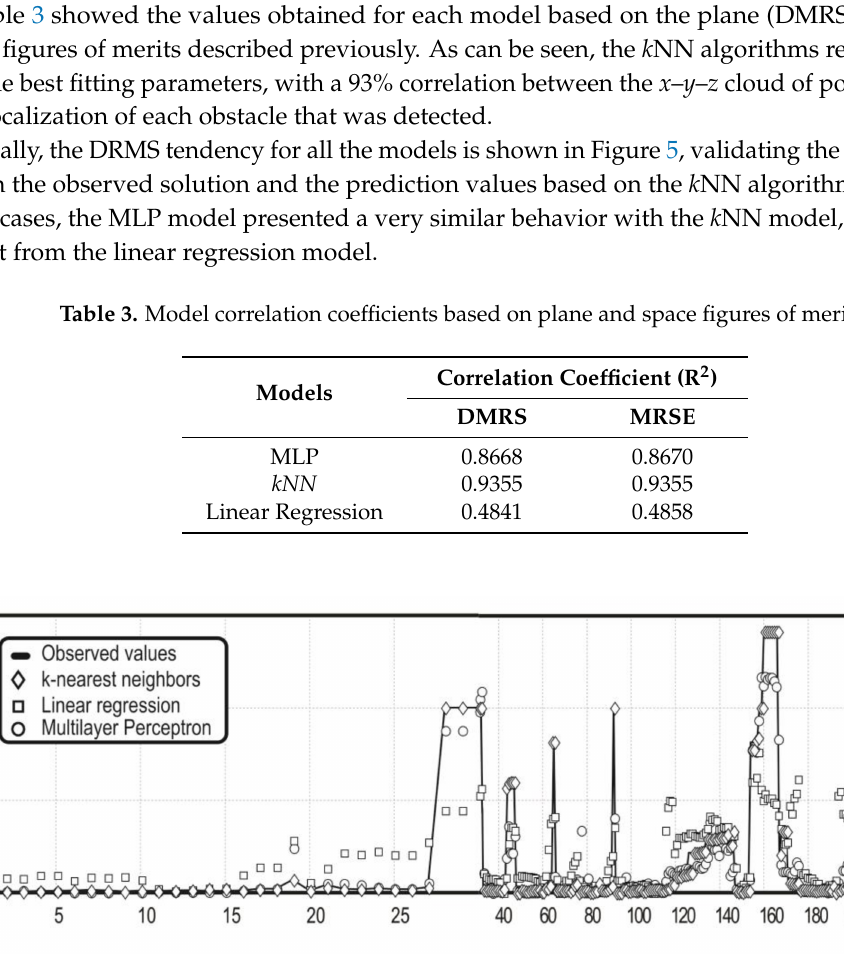
Figure 5. Prediction error behavior of the model library in the localization of obstacles by LiDAR point